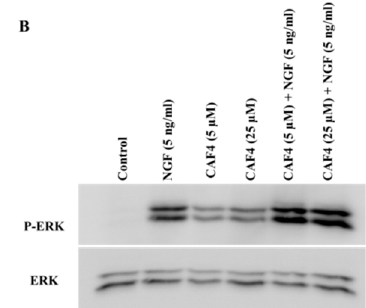
Figure 4. Assessment of TrkA phosphorylation in NIH/3T3 ‐ TrkA cells exposed to synthesized caffeate esters. NIH/3T3 ‐ TrkA cells were seeded in 12 ‐ well plates in Dulbecco’s modified Eagle’s medium (DMEM) containing 10% fetal bovine serum (FBS) for 48 h, then shifted to a low serum